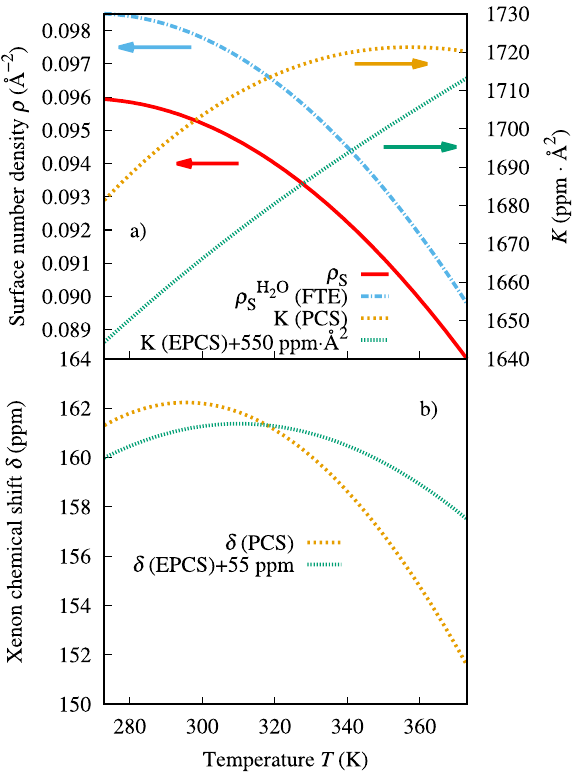
Figure 5. Factors in the semianalytical cavity model, ρ S and K , defined by Eqs (S17) and (S22) in the Supplementary Information, respectively, and their product, the xenon chemical shift, as functions of temperature. PCS and EPCS refer to the strictly binary and effective pair chemical shift functions, respectively. To render the comparison easier, offsets of 550 ppm Å 2 and 55 ppm were added to the EPCS K and δ , H O 2 respectively. S